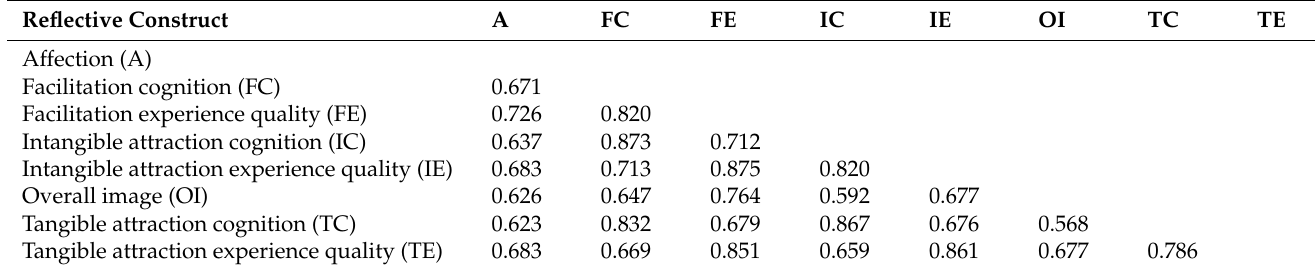
Table 8. Assessment of discriminant validity using heterotrait-monotrait ratio (HTMT).